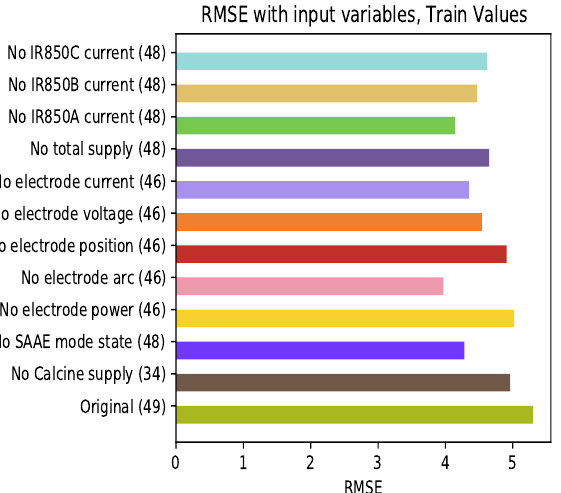
Figure 18. Average RMSE of the train set varying the learning variables at the input of the